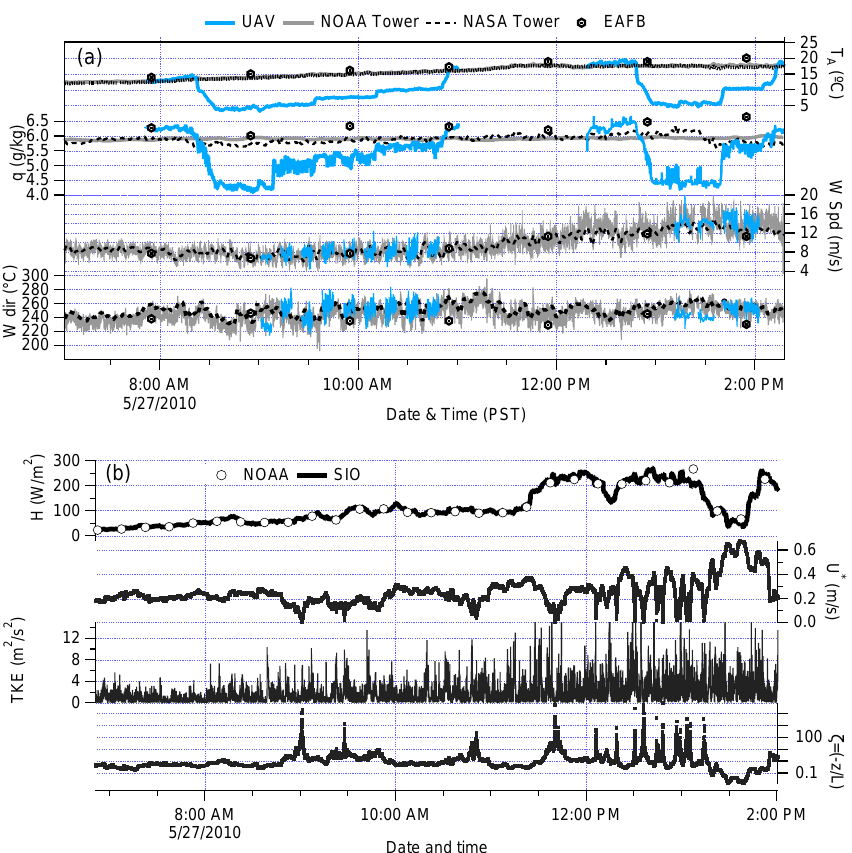
Fig. 8. (a) Time series of surface and UAV meteorological data. (b) From top to bottom: H , u ∗ , TKE and ζ derived from the sonic anemometer data on the surface tower. For a confirmation of calculation techniques, H is shown calculated with the standard NOAA and SCRIPPS UAV